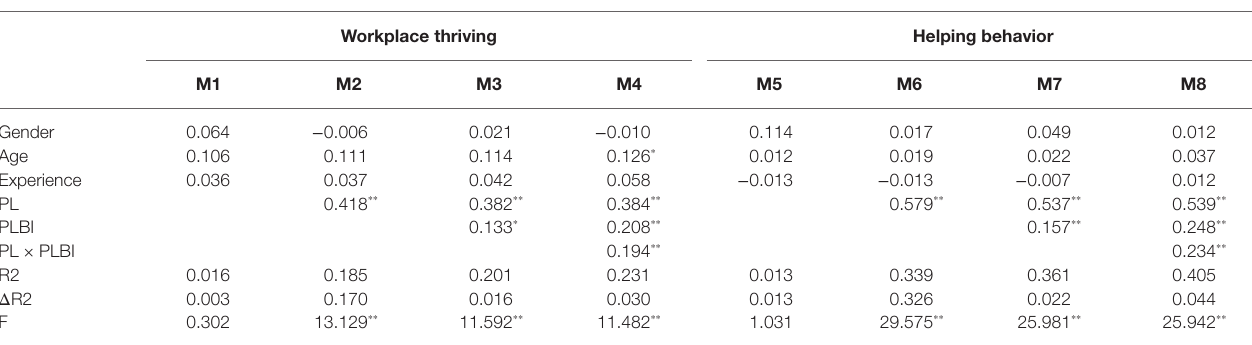
TABLE 3 | Hierarchical regression results. Workplace thriving Helping behavior